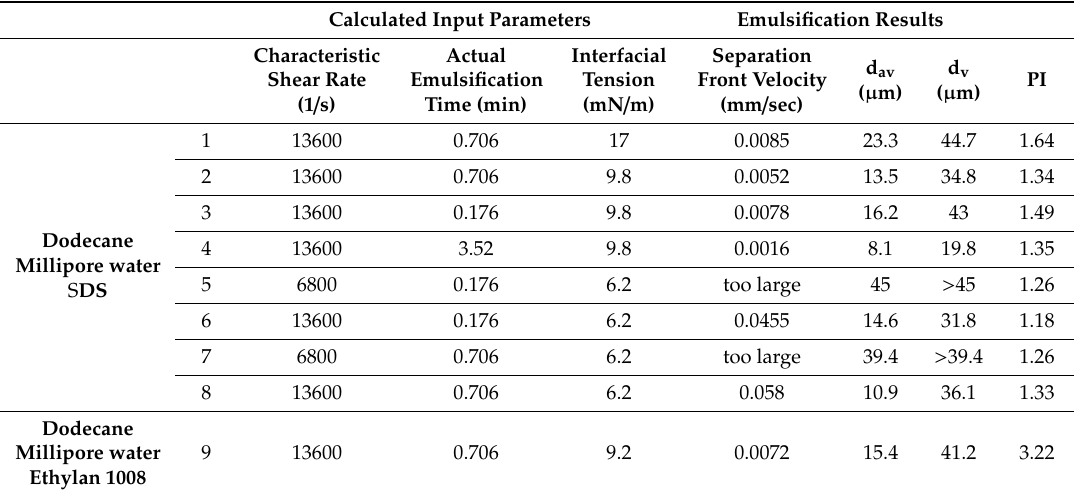
Table 3. Quantitative results of the experiments with Piston